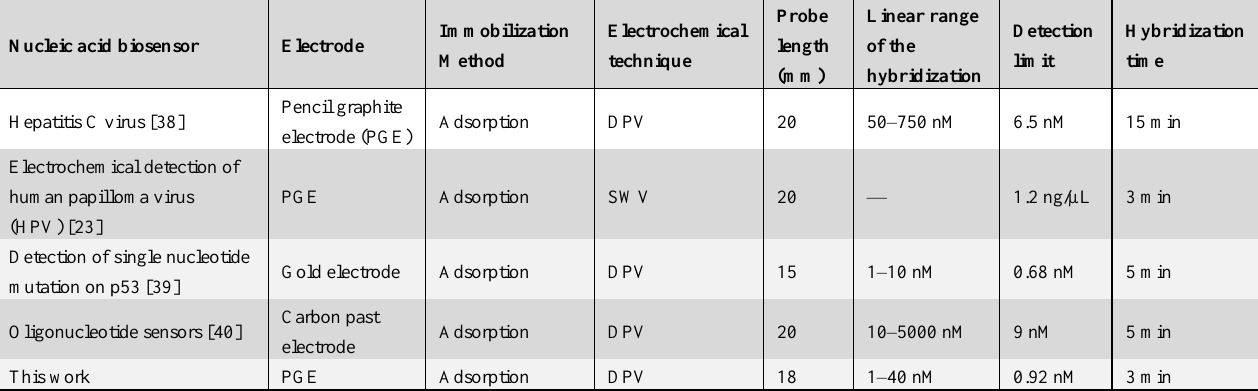
Table 1. Comparison of nucleic acid biosensors under the same immobilization conditions. Nucleic acid